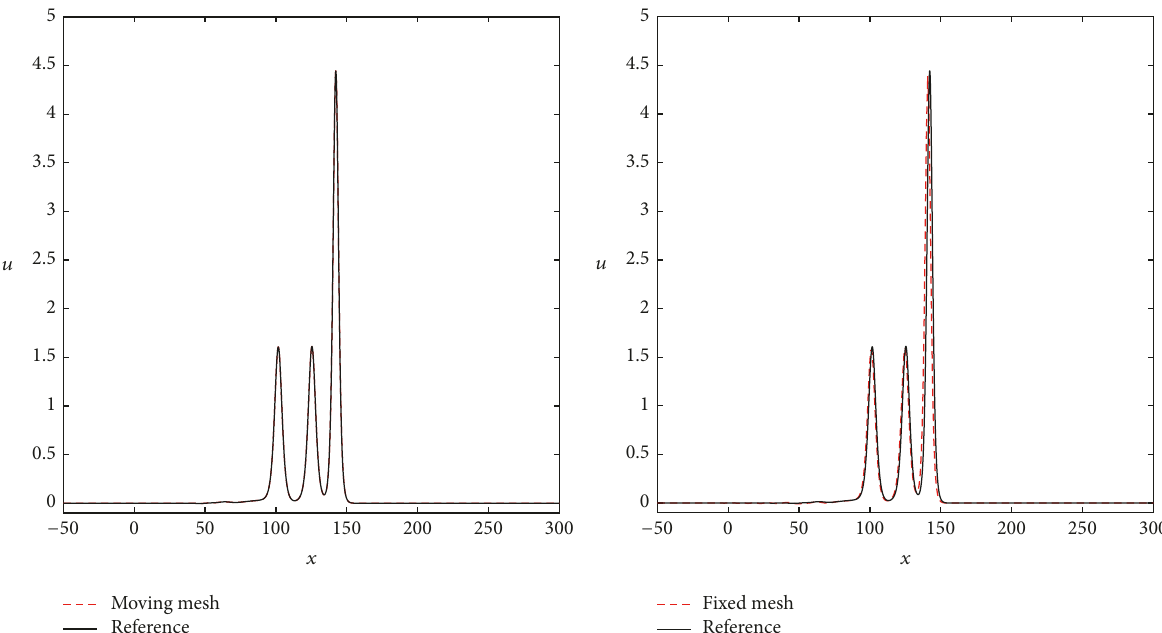
Figure 3: Example 2. The comparison between the numerical solution and the reference solution on moving and fixed meshes for the interaction of three solitary waves with 𝑁 = 400 .